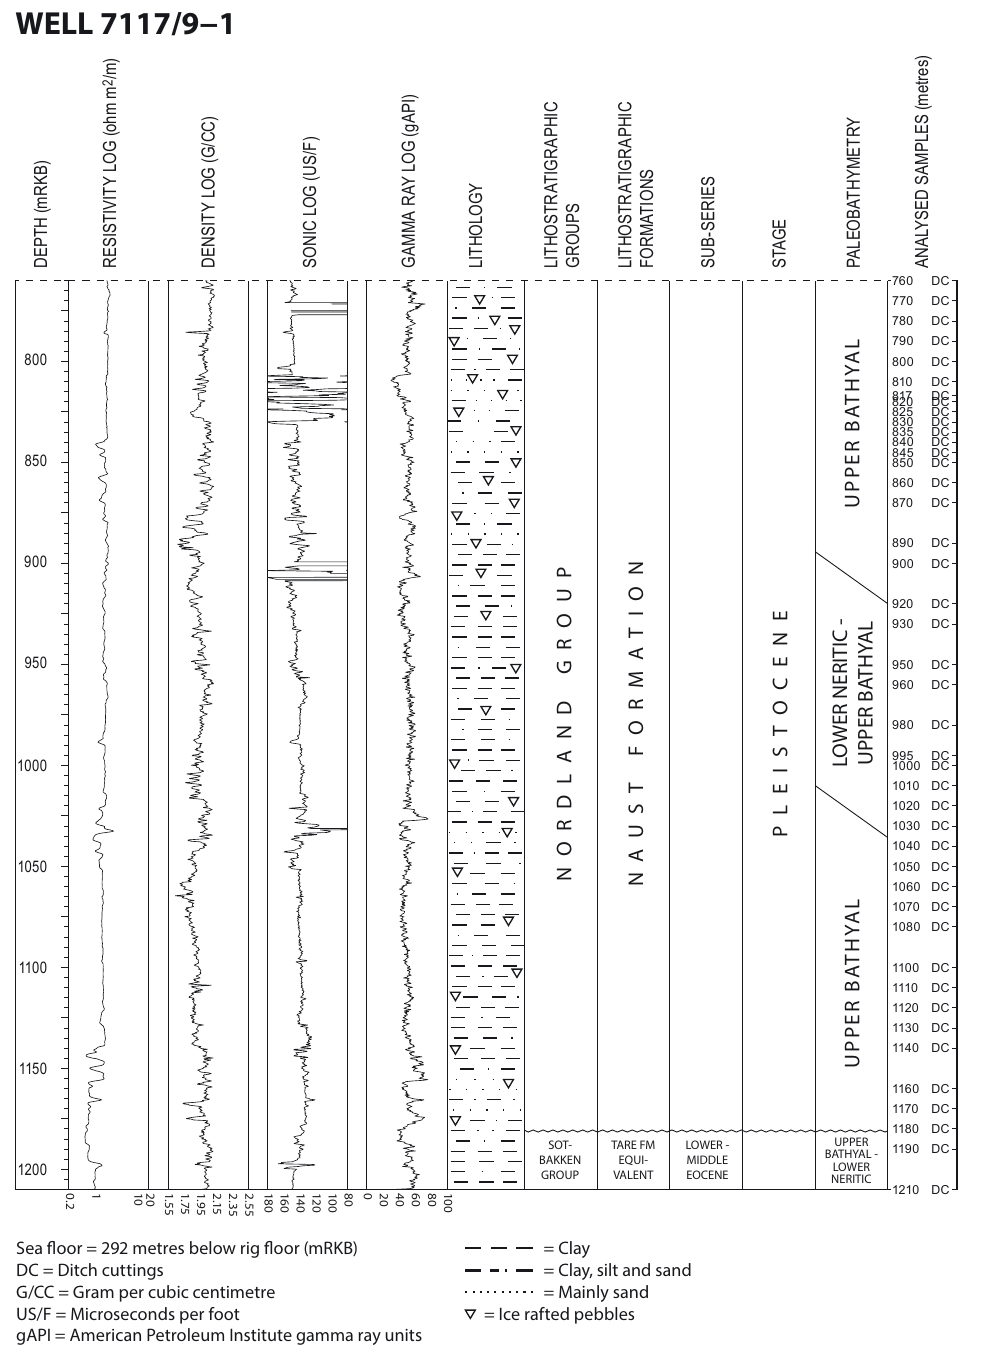
= Clay = Clay, silt and sand = Mainly sand = Ice rafted pebbles Figure 67. Well summary figure including resistivity log, density log, sonic log, gamma-ray log, lithology, litho- stratigraphic units, sub-series, stage, paleobathymetry and analysed samples for the lower part of the investigated sequence in well 7117/9–1 (lower/middle Eocene to Pleistocene) including the supplementary well reference section for the Naust Formation in the Barents Sea (lower part) (modified after Eidvin & Riis, 1989; Eidvin et al.,